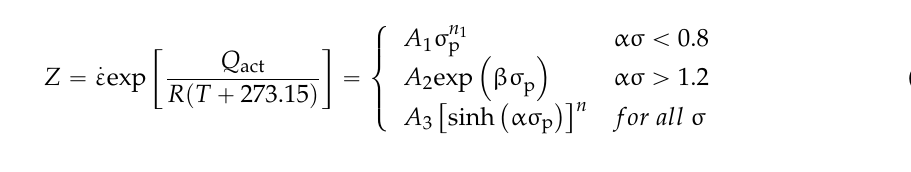
Figure 1. Flow curves for the 316LN stainless steel at: ( a ) ε =0.001 s − 1 ; ( b ) T = 1150 °C.